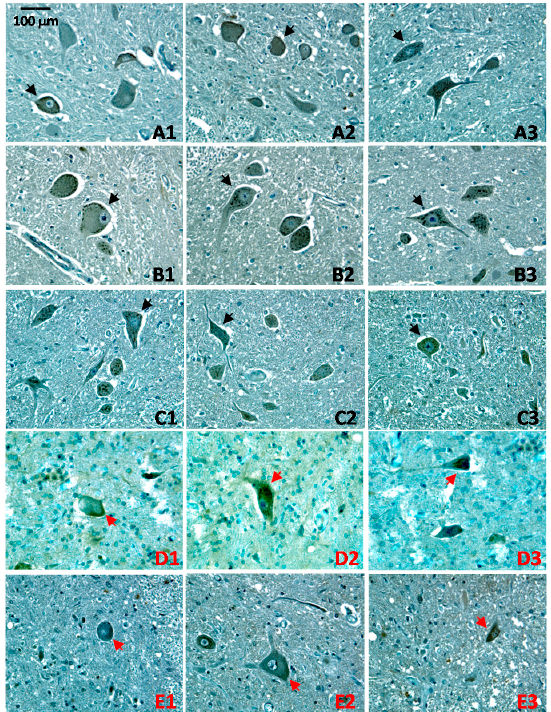
Figure 4. Altered CA1-immunoreactive patterns in ALS pathology. Spinal cord sections were immunohistochemically stained for CA1-immunoreactivity (brown, G α CA1, 1:500) and counter-stained with hematoxylin ( blue ). Three randomly selected images (indicated by 1–3) were shown for each sample. Samples labeled in black ( A – C ) are from control subjects; and those labeled in red ( D – E ) are from ALS patients. Neurons with the normal punctate CA1-immunoreactive distribution are indicated by black arrows and those with altered CA1-immunoreactive pattern were indicated by red arrows. The black scale bar indicates 100 μ m.